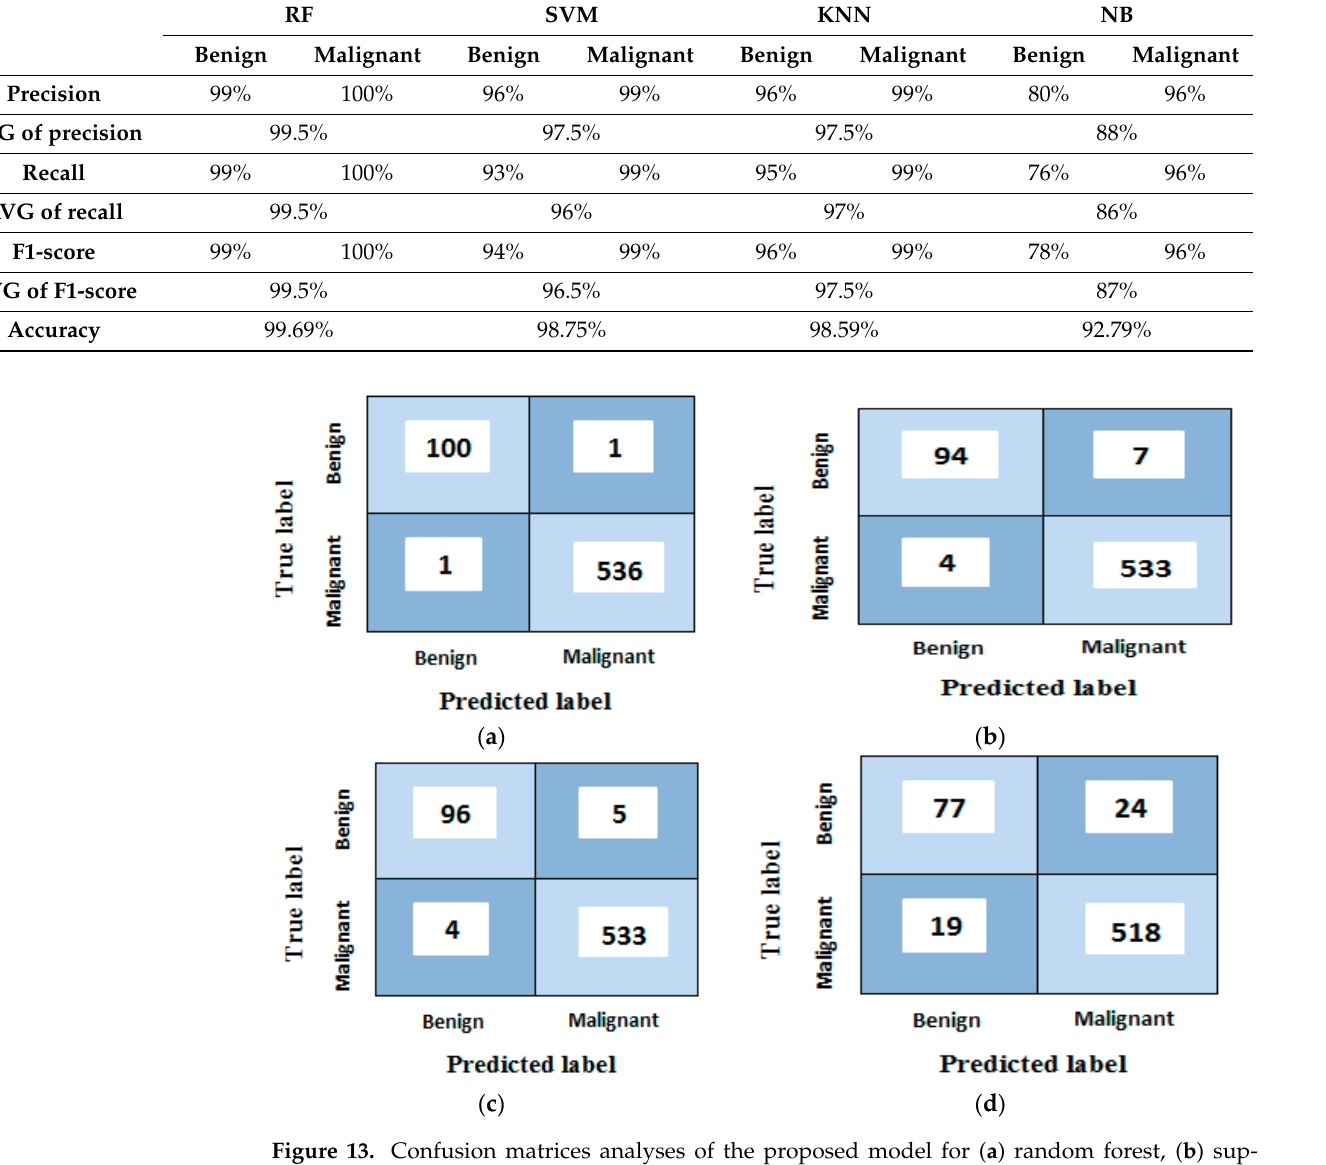
Figure 14 . Confusion matrices before and after using grey wolf optimization algorithm.